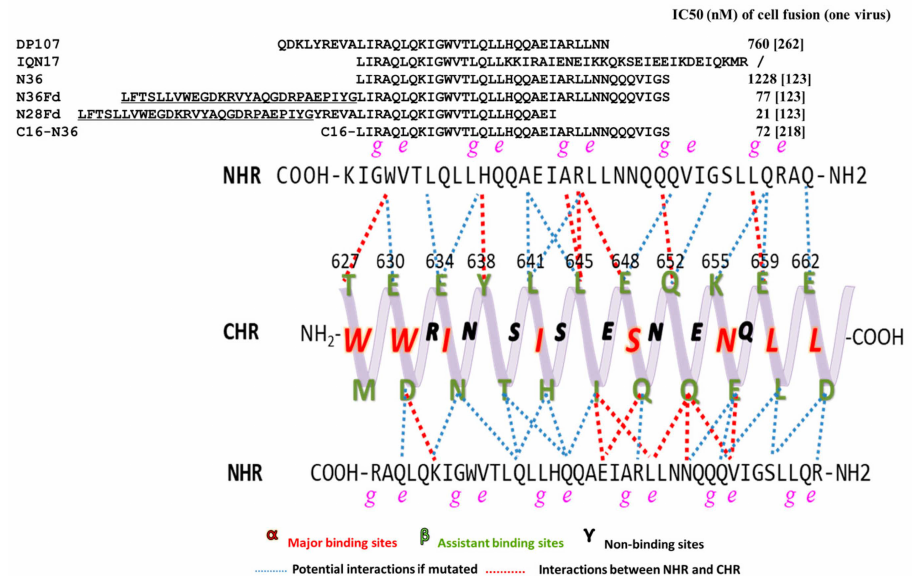
Figure 4. Tripartite model of gp41 C-terminal heptad repeats (CHR) with side view and